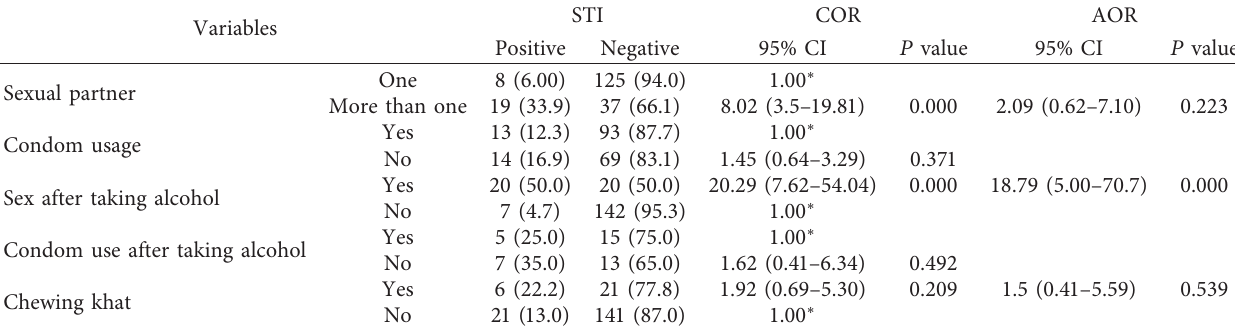
Table 2: Risk factors for sexually transmitted infections among university students ( n �